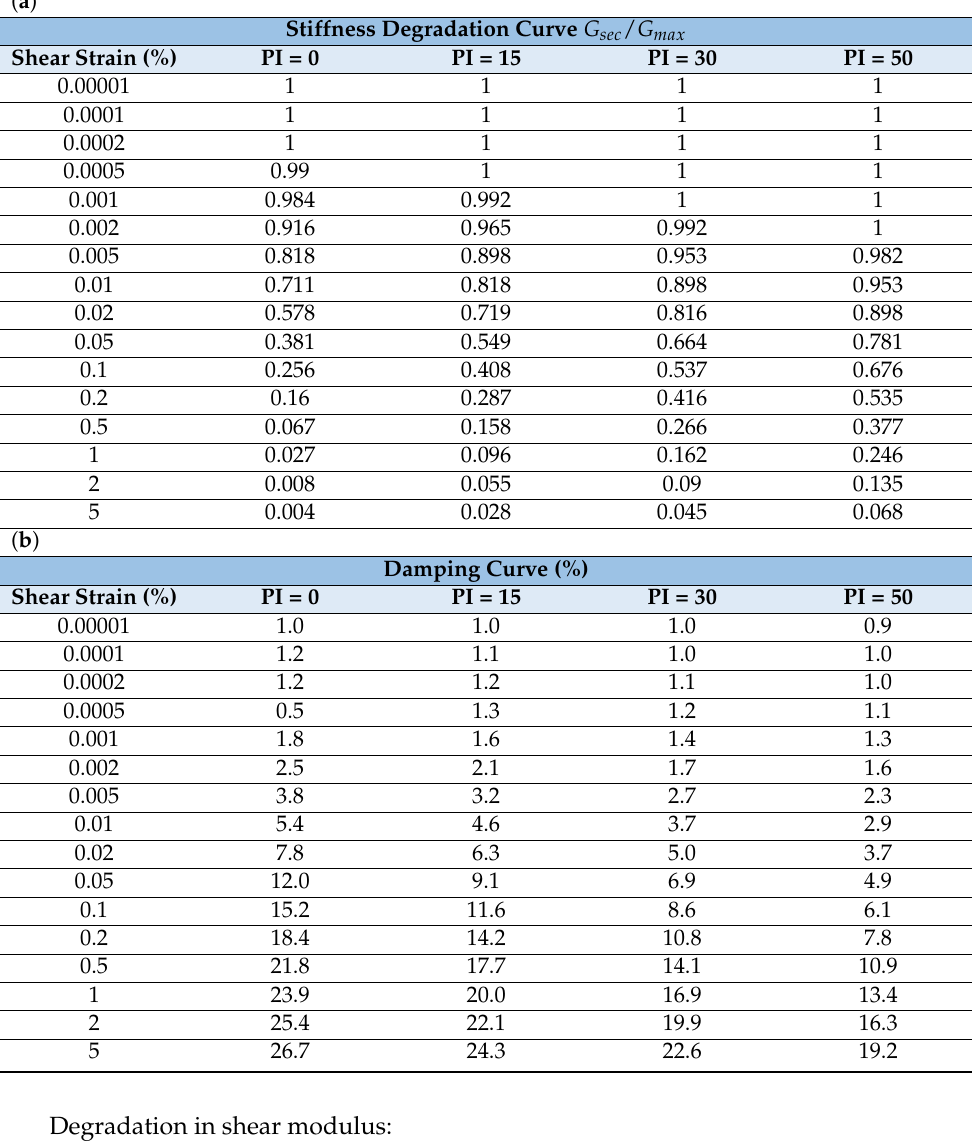
Table A2. Dynamic properties of soils (after Vucetic and Dobry): ( a ) degradation in shear modulus; ( b )